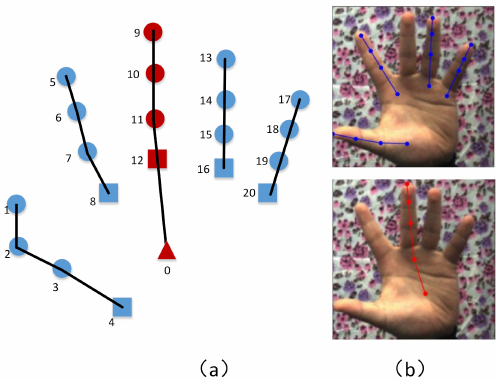
Figure 2. The diagram and examples of hand keypoint division. ( a ) Skeleton graph of 21 hand keypoints, in which triangle, square, and circle represent Palm, the metacarpophalangeal joint, and the phalangeal joint, respectively. The middle finger containing the Palm is marked in red, and others are marked in blue. ( b ) An example diagram of different finger keypoints from the real dataset Stereo Hand Pose Tracking Benchmark (STB).